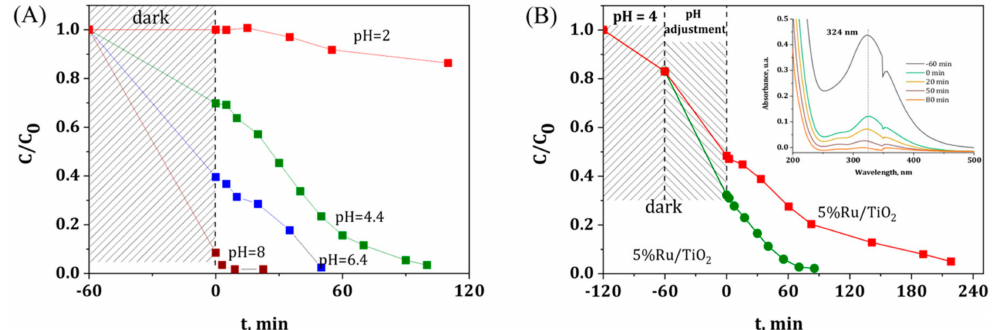
Figure 5. ( A ) Influence of the solution pH on the disappearance of the RuCl 3 precursor in the presence of TiO 2 -P25 as a function of the illumination time for a Ru content of 0.5 wt.%. ( B ) Disappearance of the RuCl 3 precursor in the presence of TiO 2 -P25 as a function of the illumination time at pH = 6.4 and pH = 8.0, with a Ru content of 5 wt.%. Inset: UV-vis absorbance spectra evolution as a function of time during the photon-assisted synthesis of Ru(5 wt.%)/TiO 2 at pH =